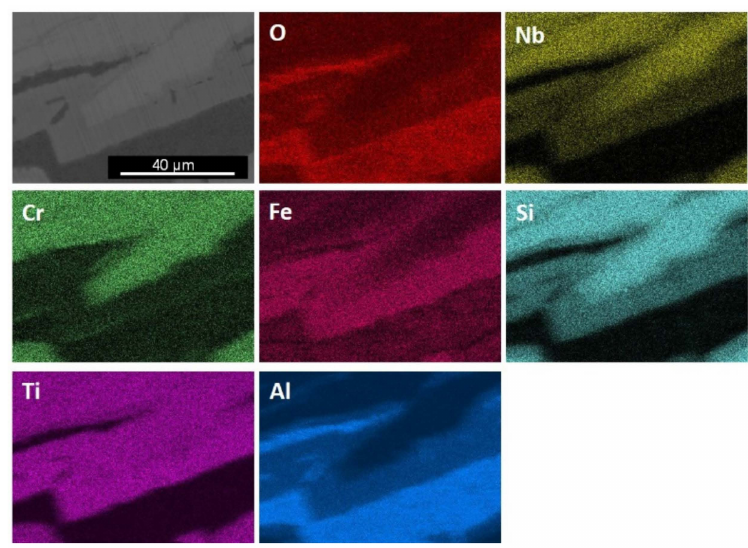
Figure 10. X-ray elemental maps of scale surface after isothermal oxidation at 800 ◦ C for 100 h, BSE